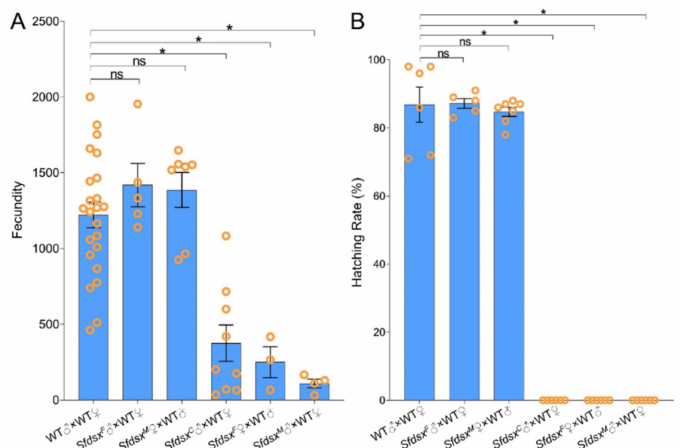
Figure 5. Compromised fecundity and fertility after Sfdsx mutagenesis. ( A ) Adult mutants of Sfdsx injected with common, female-, and male-specific sgRNAs and Cas9 showed decreased fecundity compared to the wildtype. ( B ) The hatching rates of eggs laid by Sfdsx C males, Sfdsx F females, and Sfdsx M males are shown. The asterisks (*) indicate significant differences ( p < 0.05) between mutants and wildtypes. “ns” stands for “not significant” ( p > 0.05). Data were analyzed using